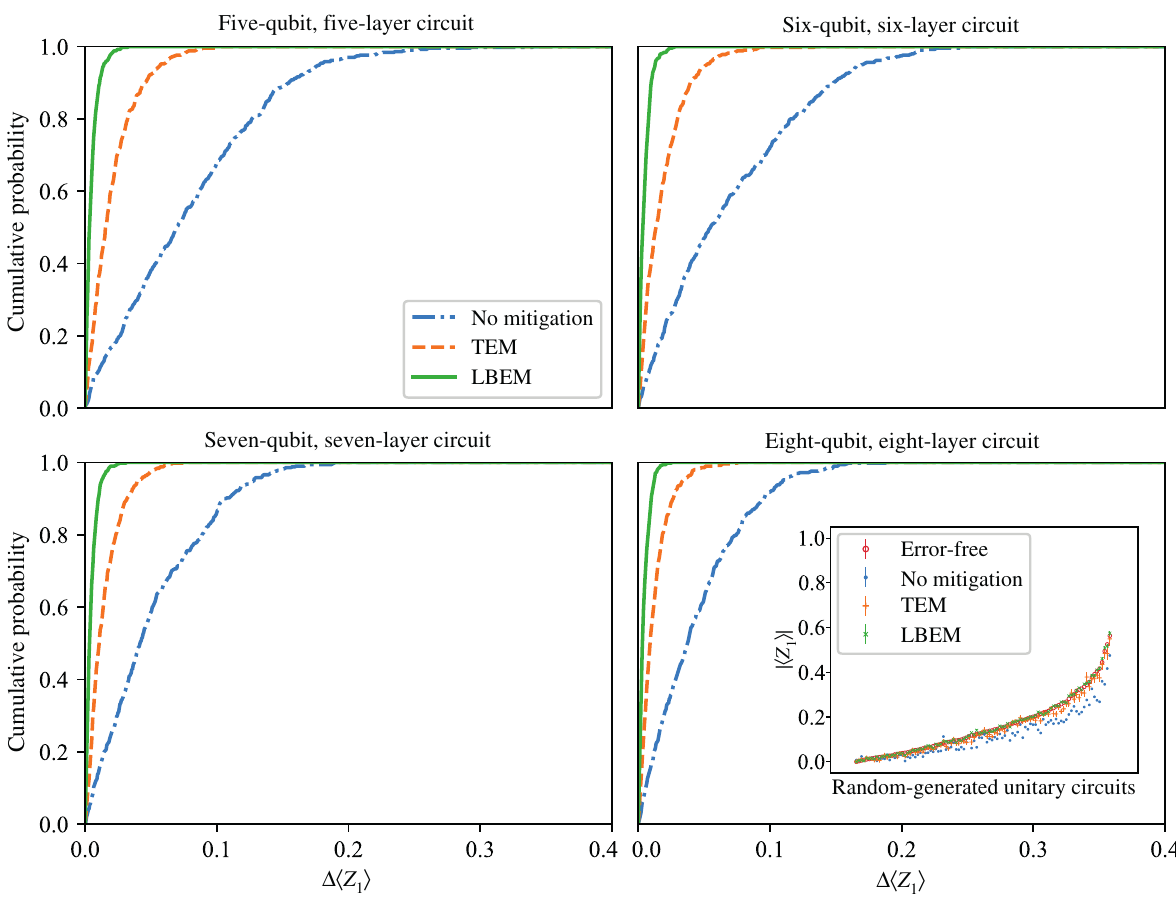
FIG. 7. Empirical cumulative distribution function of estimated (cid:7) (cid:10) Z 1 (cid:2) = |(cid:10) Z 1 (cid:2) − (cid:10) Z 1 (cid:2) EF | for 500 configurations of randomly gener- ated computing gates R . Each computing gate is uniformly sampled from the single-qubit unitary group according to the Haar measure. For each computing-gate configuration, M = 10 000 random configurations of error-correcting gates P are generated to evaluate the error-mitigated result. In the inset in (d), we show (cid:10) Z 1 (cid:2) of 100 configurations for the eight-qubit circuit. Error bars represent estimated standard